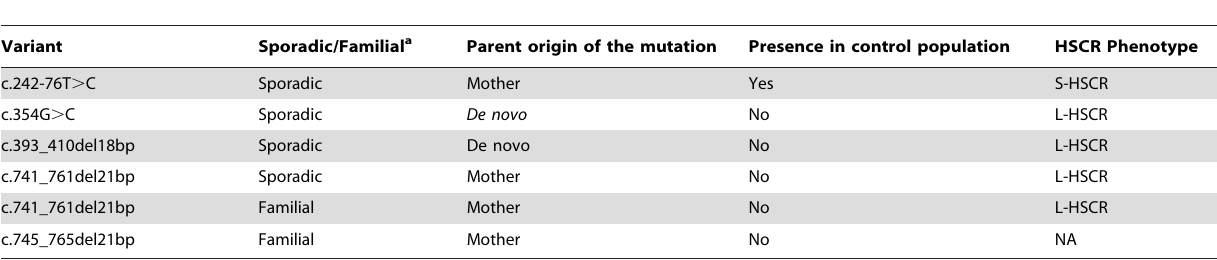
Table 2. PHOX2B variants identified in HSCR